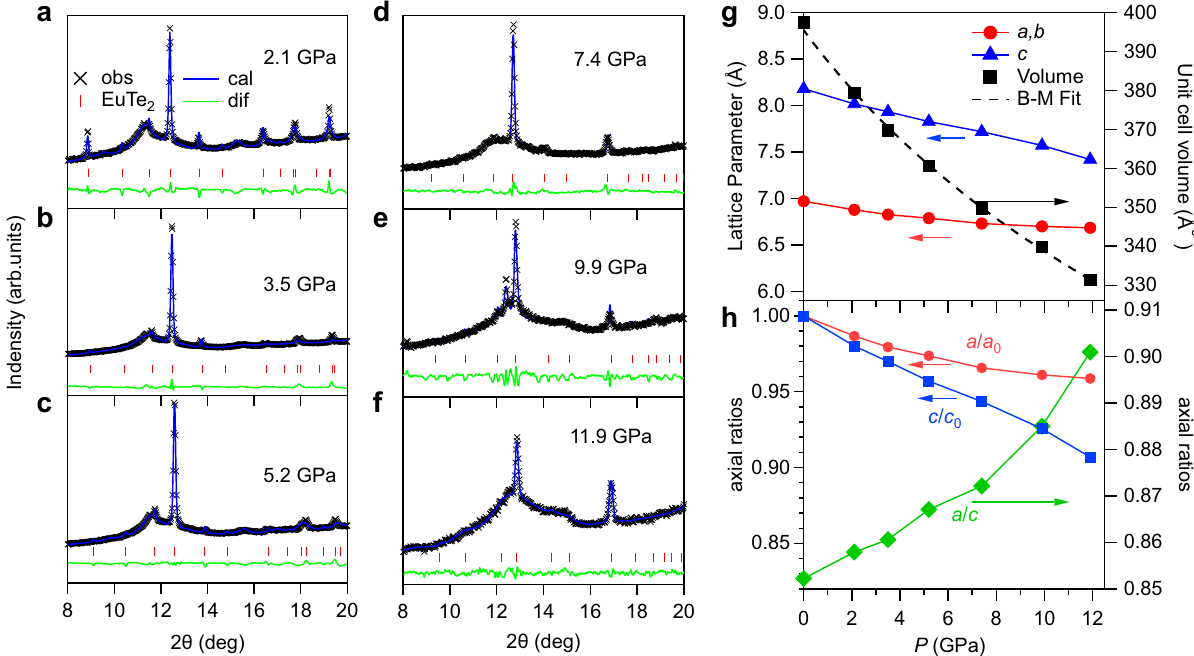
Fig. 6 Structural evolutions of EuTe 2 under high pressure. a – f High-pressure synchrotron X-ray diffraction under various pressures up to 11.9 GPa at room temperature. g , h Pressure dependence of lattice parameters ( a , b , c , volume V ) and the relative shrinkage of lattice parameters a / a 0 , c / c 0 and the axis ratio a / c . In g , the Birch – Murnaghan (B – M) isothermal equation of state was adopted to fi t the pressure dependence of volume V ( P ). A clear slope change in a / a c / c a / c can be found around 7 0 , 0 , and